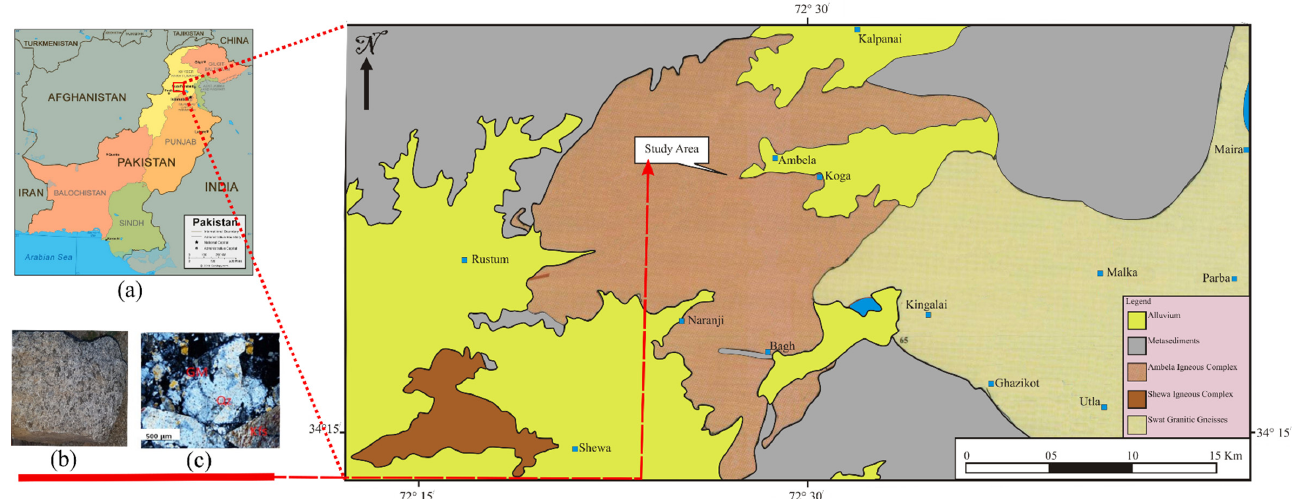
Figure 1. ( a ) Pakistan map and regional geological map showing the distribution of the Cambrian to Ordovician Swat Granite Gneisses, metasedimentary rocks, ranging in age from Late Proterozoic to Late-to-Middle Mesozoic and Late Carboniferous to Permian Ambela and the Shewa Igneous complex; ( b ) granite boulder; ( c ) micrographs of the thin sections (cross-polarized light).